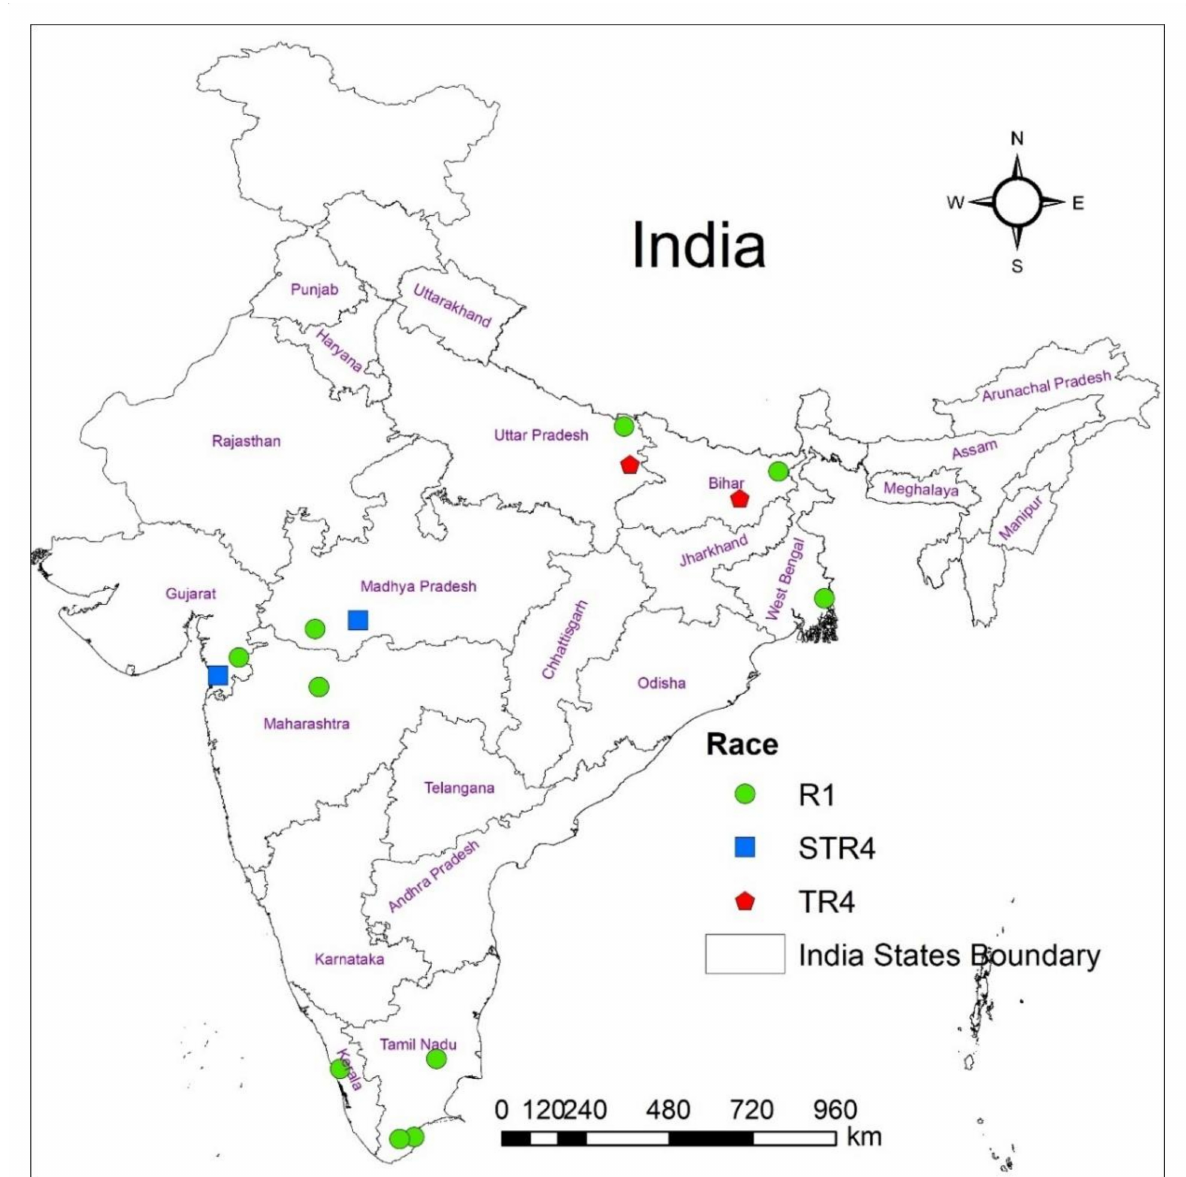
Figure 1. Distribution of Foc races across the different states of India. Color and shape denote Foc races infecting Cavendish